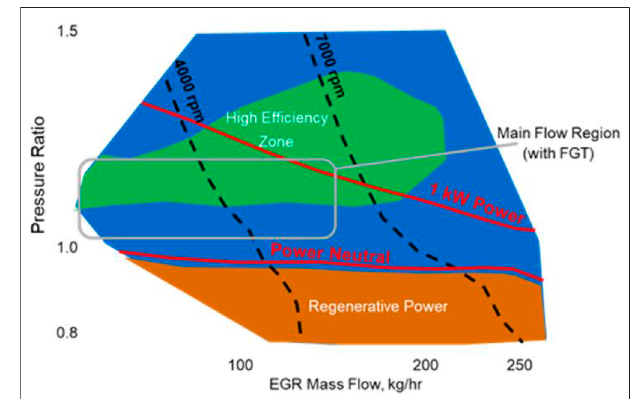
FIGURE 11 | Pressure pulsations for without back fl ow, two sides back fl ow, and angled port with two sides back fl ow port designs at 10,000 rpm and PR-1.3.